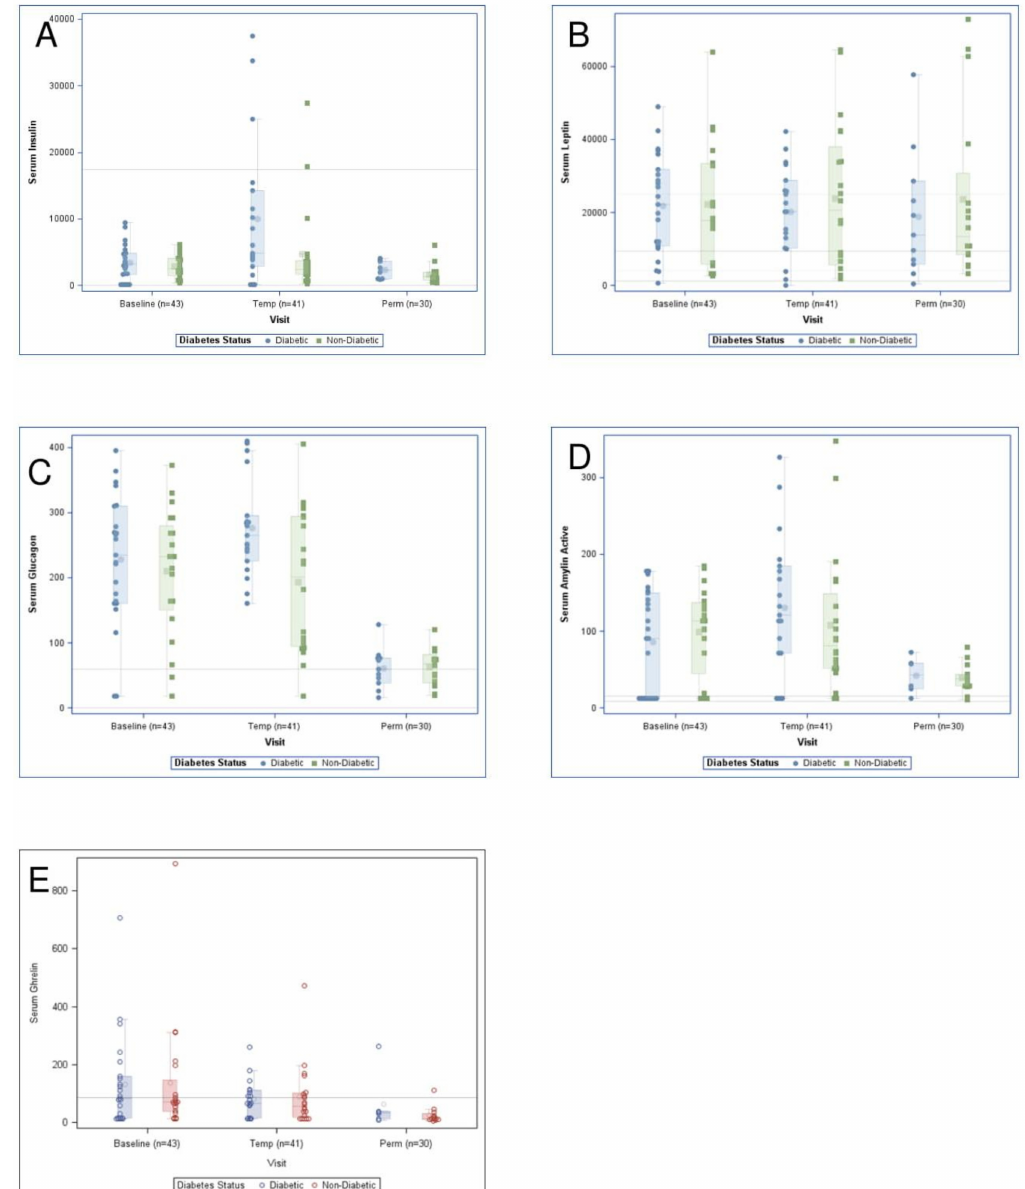
Figure 4. Hormonal stabilization e ff ect. Stratified changes over the observational period (baseline, 6 days and 6 months) of serum levels of insulin ( A ), leptin ( B ), glucagon ( C ), amylin ( D ), and ghrelin ( E ) in response to low and medium energy GES